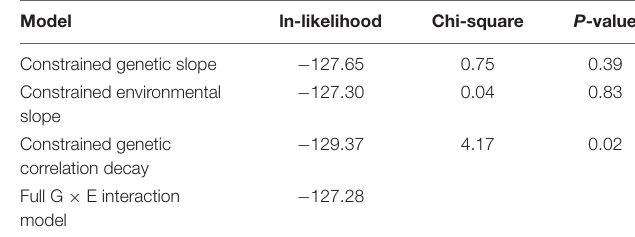
TABLE 5 | Testing the critical parameters of the full G × E interaction model for